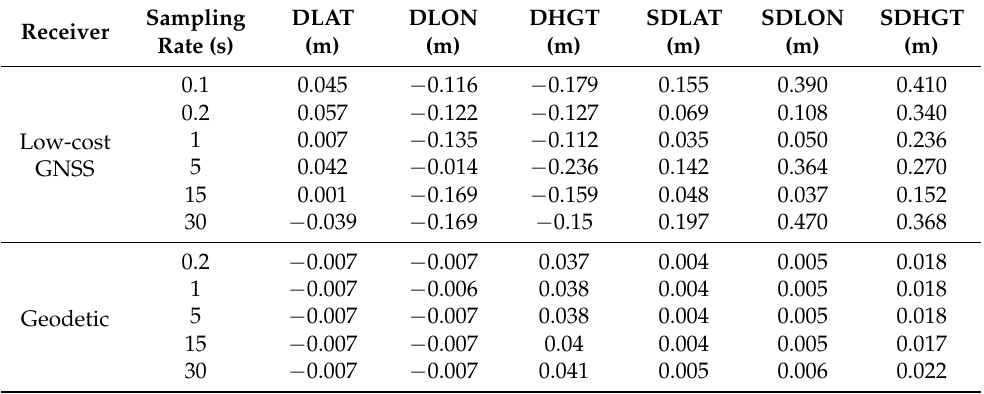
Figure 9. Standard deviation (95%) of estimated positions by processing with PPP-static mode: ( a ) low-cost receiver at 0.1 s; ( b ) geodetic receiver at 0.2 s. Table 2. Differences and Standard deviation obtained at different sampling rates for the PPP- static